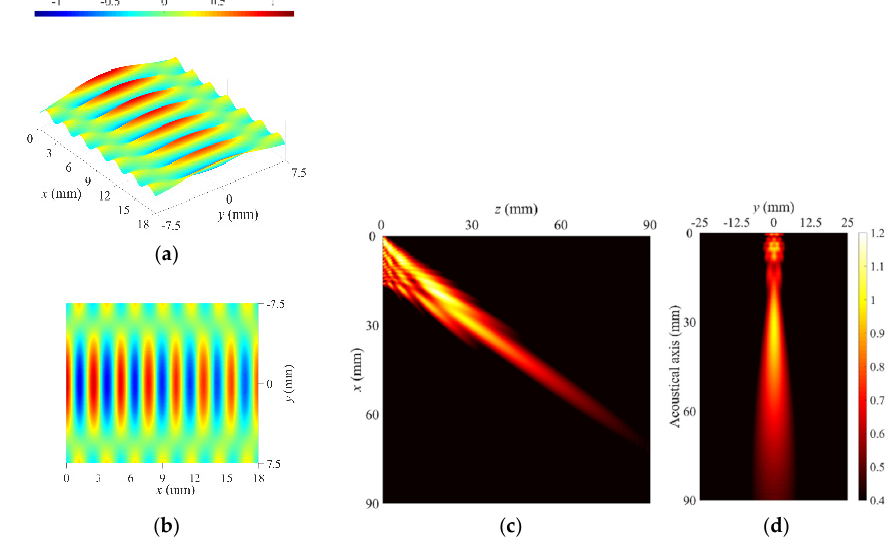
Figure 13. Simulation #2 of the leaky radiation beam profile based on the wave phase on the radiation surface. ( a ) Isotropic view of wave phase on radiation surface, ( b ) top view of wave phase on radiation surface, ( c ) vertical beam profile, and ( d ) lateral beam profile.